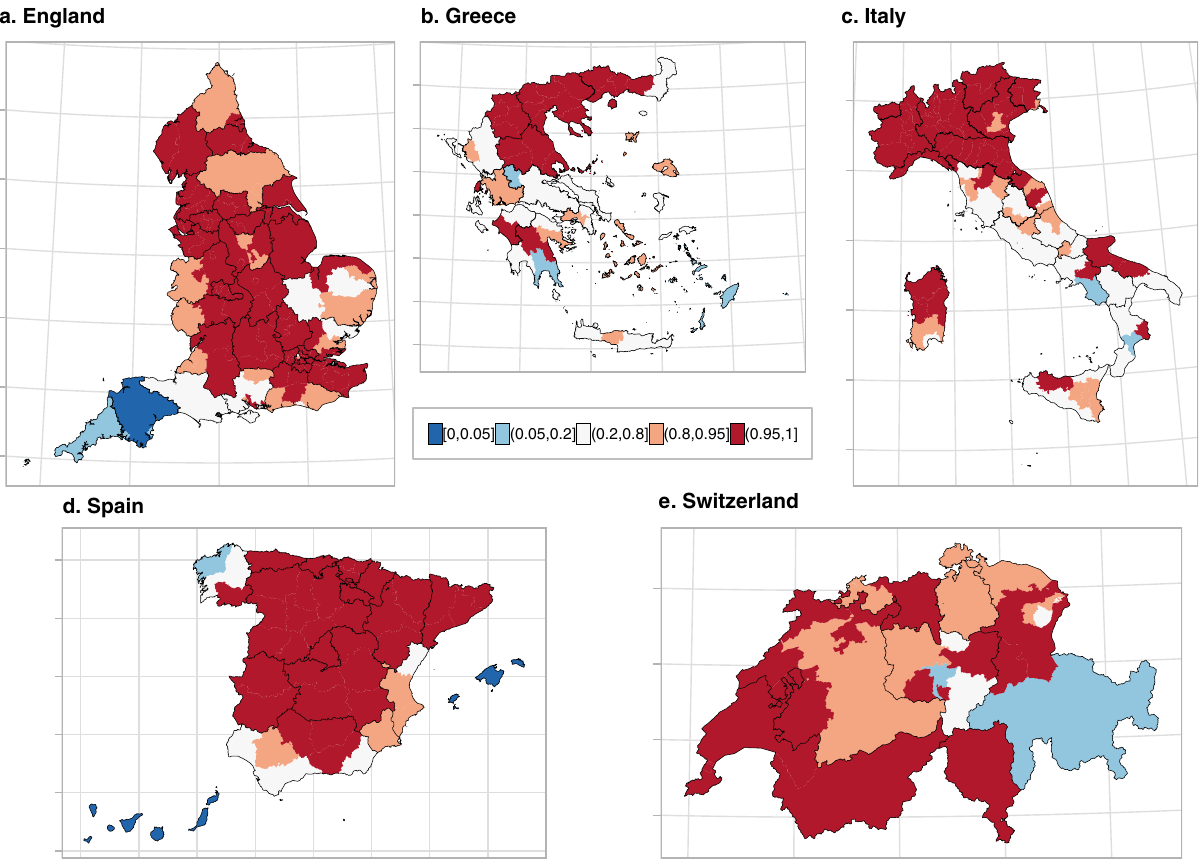
Fig. 3 Probability that the relative excess deaths is higher than 0% by NUTS3 region in 2020. a Probability that the relative excess deaths is higher than 0% in England. b Probability that the relative excess deaths is higher than 0% in Greece. c Probability that the relative excess deaths is higher than 0% in Italy. d Probability that the relative excess deaths is higher than 0% in Spain and e probability that the relative excess deaths is higher than 0% in Switzerland. Areas in blue indicate areas that observed less deaths than expected had the pandemic not occurred, whereas the different shades of red indicate the higher relative excess mortality. The black solid lines correspond to the NUTS2 region